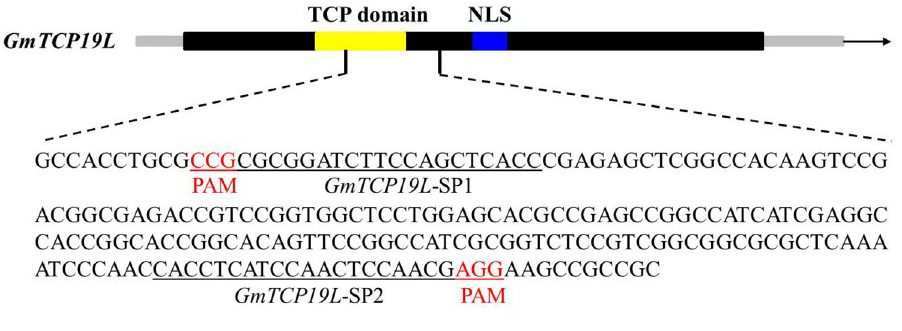
Fig 1. Gene structures of GmTCP19L with target sites. The underlined nucleotides indicate the target sequences, and the red nucleotides indicate PAM sequences.